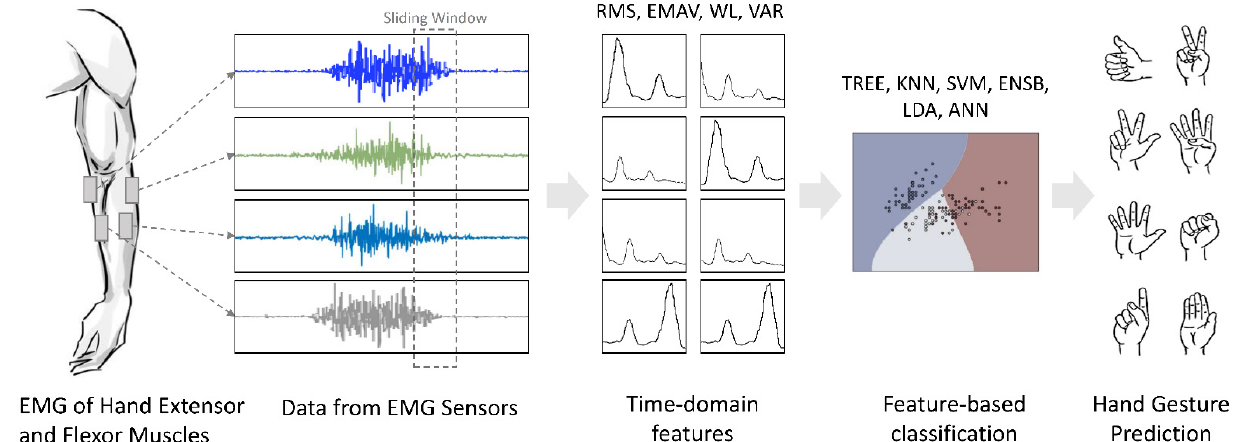
Figure 2. Feature-based learning for classification of hand gestures using NinaPro dataset.